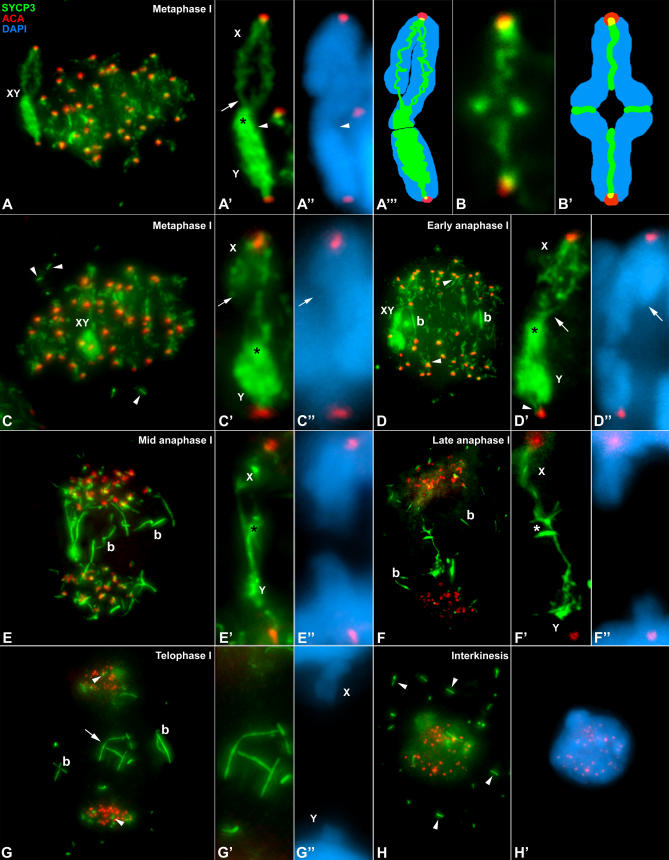
Immunolabeling of Squashed Spermatocytes with Anti-SYCP3 (Green) and Anti-Centromere (Red) AntibodiesSeveral focal planes have been superimposed and projected in each image.(A) Metaphase I. Bivalents are correctly bioriented in the metaphase plate, including the XY pair.(A′–A′′) SYCP3 is detected on the X chromosome as an irregular line (with small splittings and excrescences) covering the interchromatid domain. The Y chromosome is completely labeled with the anti-SYCP3 antibody. Comparison of SYCP3 and DAPI images shows that this massive labeling also involves the distal region of the X chromosome long arm (asterisk in A′–A′′). The distal region of the long arm of the X chromosome contacts with the Y chromosome (arrowhead) while an SYCP3 filament overpasses the X short arm and links to the distal region of the X long arm and the Y chromosome (arrow).(A′′′) Schematic illustration of the XY pair in this stage. The limit between both sex chromosomes is marked.(B) Shown is an autosomal bivalent in metaphase I, and (B′) its schematic representation. SYCP3 signal runs along the interchromatid domain and interrupts at the chiasma point.(C–C′′) Metaphase I: In this spermatocyte bivalents are correctly bioriented in the metaphase plate, including the XY pair. Some aggregates of SYCP3 are detected in the cytoplasm (arrowheads). In this case, the SYCP3 bridge from the X chromosome short arm is broken (arrow in C′ and C′′), while the long arm is still in contact with the Y chromosome (asterisk).(D–D′′) Early anaphase I: SYCP3 begins to dissociate from the autosomes as they migrate to the poles, but some SYCP3 is still present near some centromeres (arrowheads) and along some regions of the chromosome arms. Bar-shaped SYCP3 aggregates appear in the spindle area of the cytoplasm (b). Although sex chromosomes initiate their migration they remain linked by an SYCP3 bridge. Note that in this case the filament protruding from the X short arm is still visible (arrow in D′). SYCP3 signal exceeds the end of the X chromosome short arm (arrow in D′′). SYCP3 is detected as a filament in the pericentromeric region of the Y chromosome (arrowhead in D′), in contrast with the massive signal observed on it. The SYCP3 massive labeling has partially disorganized but it does not disappear (asterisk). During mid (E–E′′) and late anaphase I (F–F′′), this massive SYCP3 joining between X and Y chromosomes disorganizes, making it difficult to unequivocally identify sex chromosomes as they move apart from each other (their putative location has been indicated as X and Y). A series of thick filaments are present between chromatin masses migrating to opposite poles (asterisk).(G–G′′) At telophase I thick SYCP3 filaments are visible in the cytoplasm between the cell poles (arrow) and also around some centromere regions (arrowheads).(H) Interkinesis. Minute bars of SYCP3 are still detected in the cytoplasm (arrowheads).